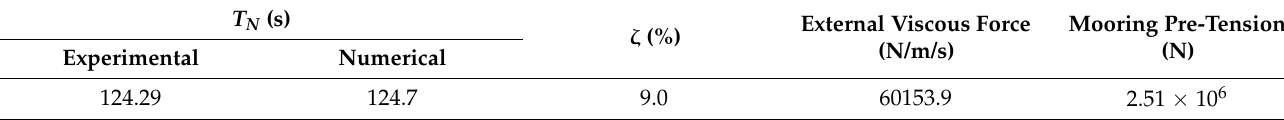
Table 5. Comparison between experimental and numerical results for heave, pitch, and surge response in regular waves for H = 1.404